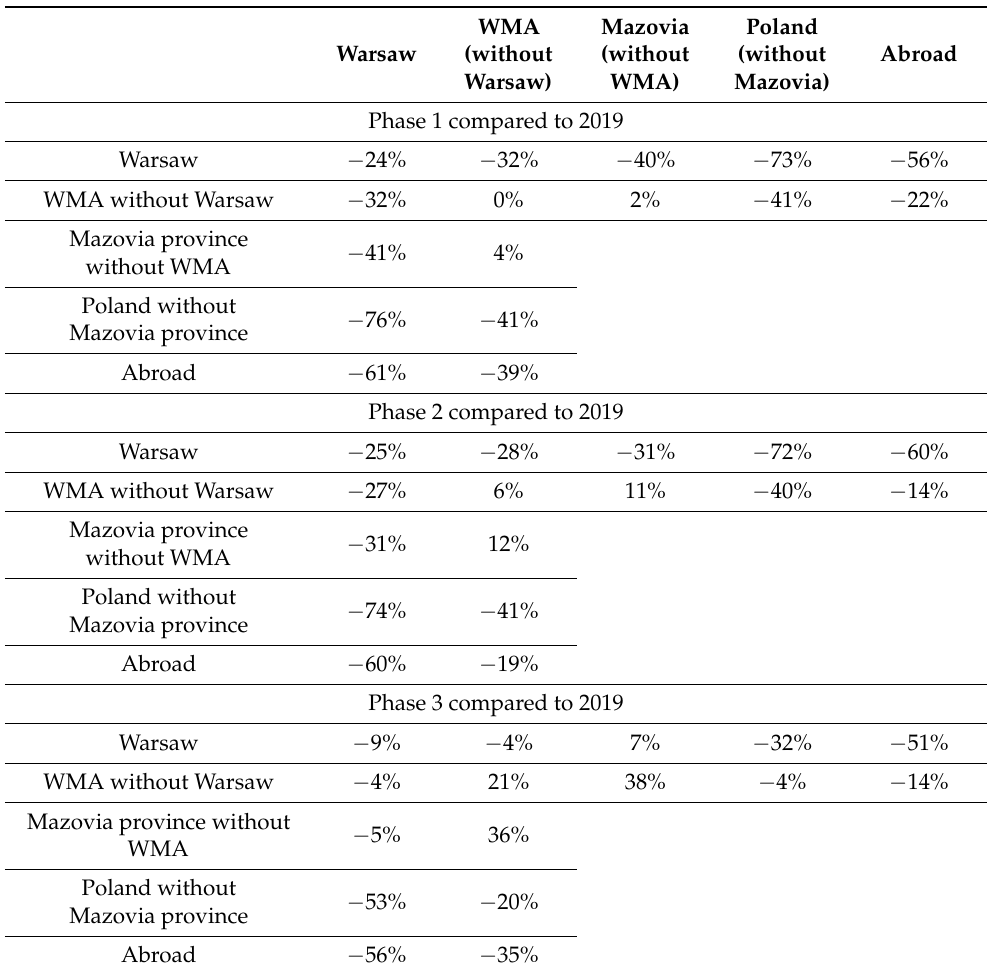
Table 1. Average daily trip numbers by phase of year 2020 compared to baseline year 2019 (without